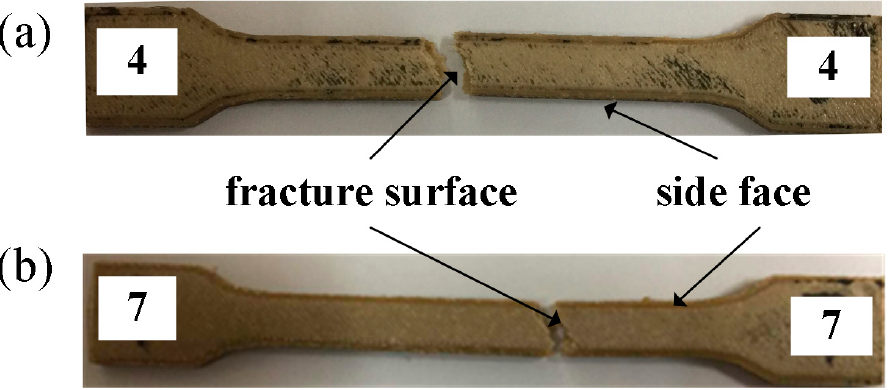
Figure 5. Fractured tensile specimens. ( a ) No. 4 specimen in Table 3; ( b ) No. 7 specimen in Table 3.